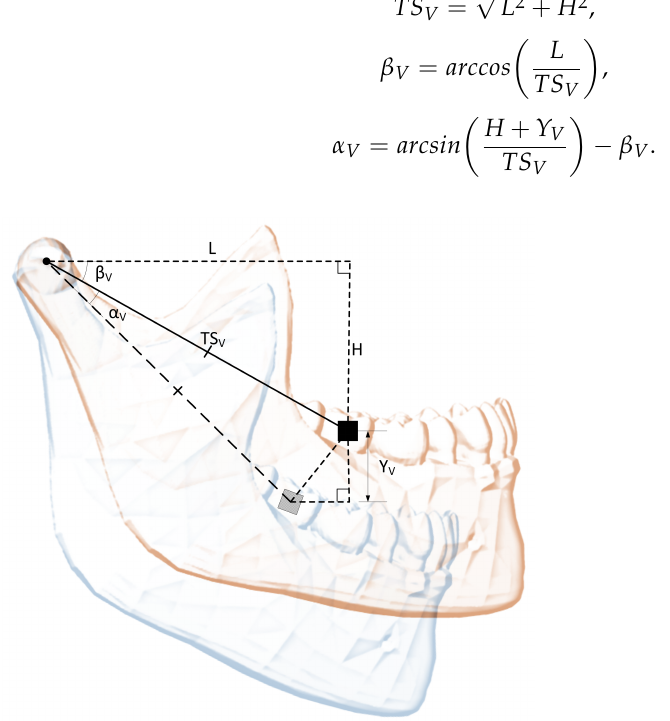
Figure 2. Vertical rotation angle relation to vertical linear displacement. Based on